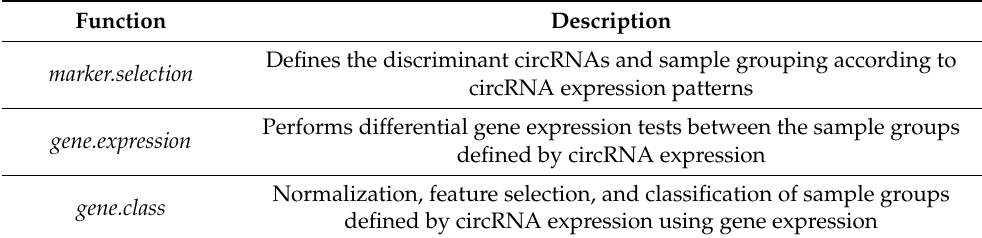
Table 1. The functions implemented in